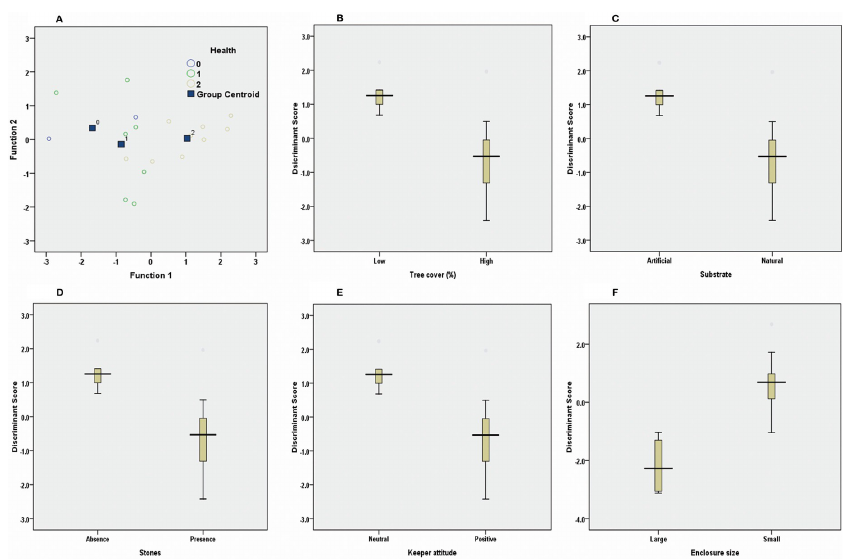
Fig 1. Plots of Canonicaldiscriminant scores obtainedfrom DFA to differentiate variables(1A: Health, 1B: Tree cover, 1C: Substrate, 1D: Stone, 1E: Keeper attitude and 1F: Enclousresize) that show significancein MANOVA.